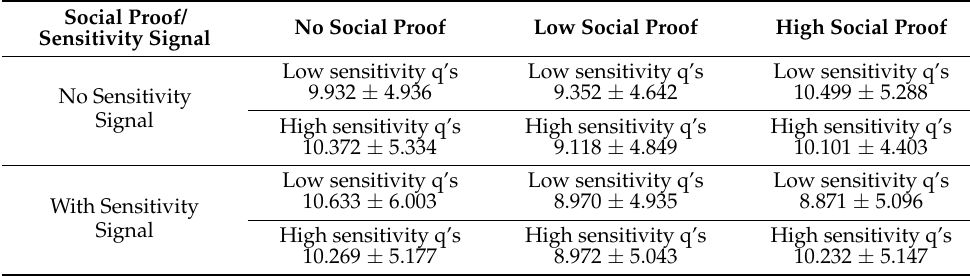
Table 8. Arousal Per Nudge Combination and Question